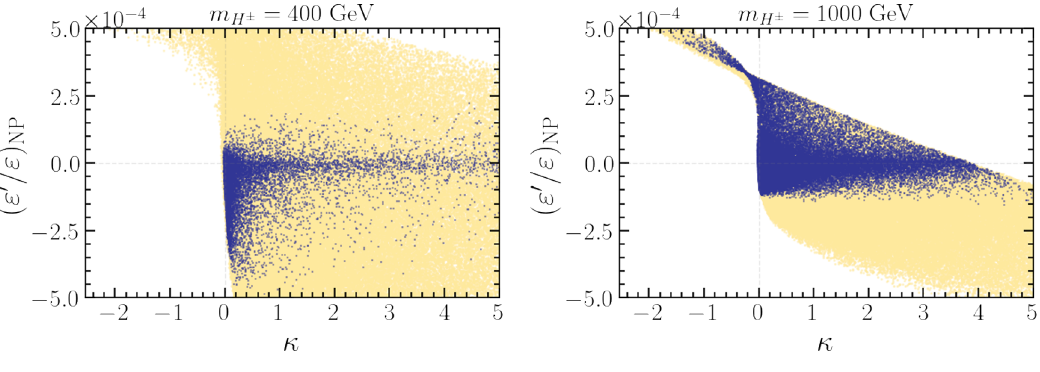
Figure 5 . Scatter plot showing range of values accessible in g2HDM for ε NP parameter scan using eq. (4.1). The yellow points are obtained with no experimental constraint imposed, while blue points are obtained after imposing B sector constraints of table